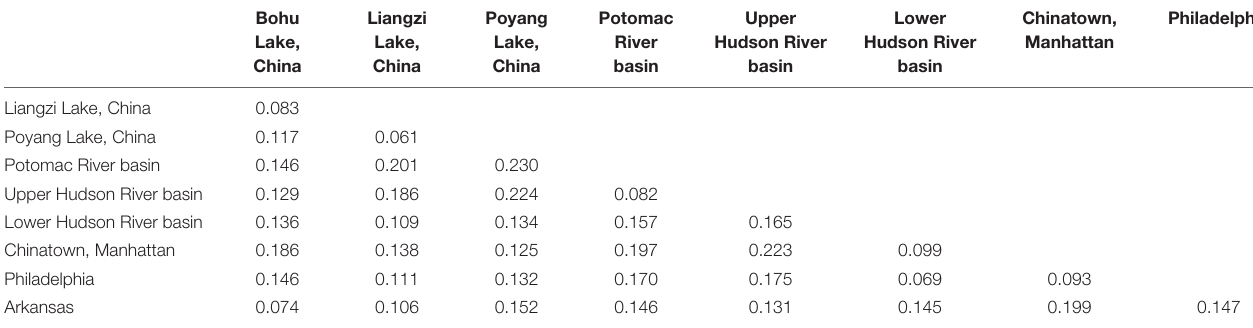
TABLE 2 | Pairwise genetic distances (Fst) between Channa argus putative